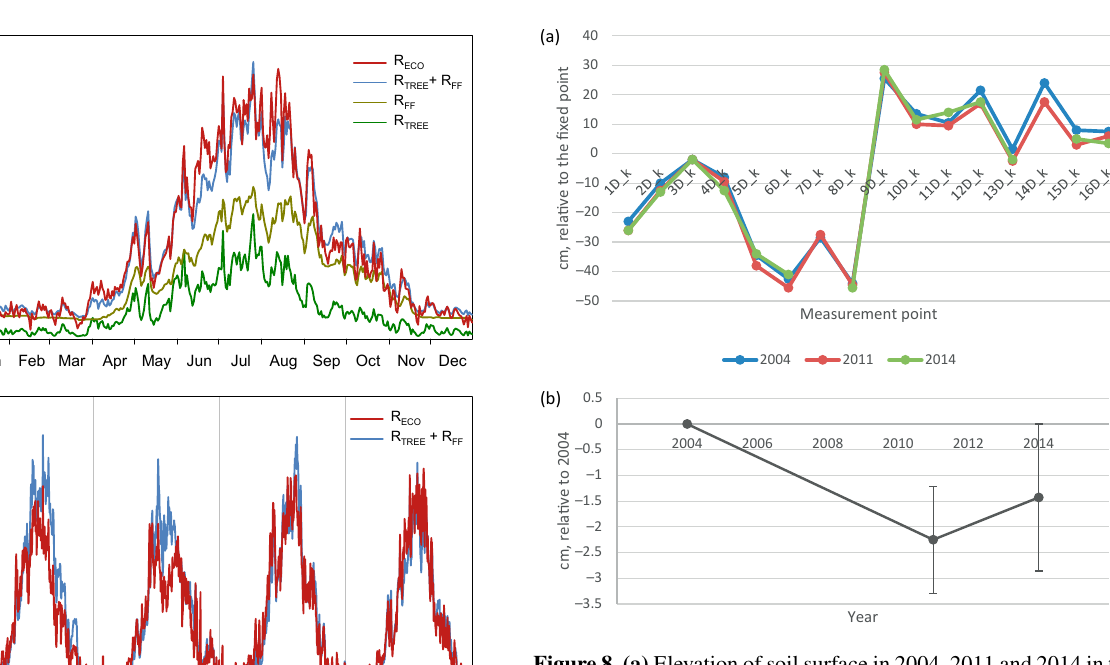
Figure 8. (a) Elevation of soil surface in 2004, 2011 and 2014 in the middle of the undisturbed D plots, relative to the fixed benchmark beside the EC mast. (b) Change in elevation relative to 2004, mean and 2 · standard error of the mean. Only the points measured at every occasion are included in the mean and SEM